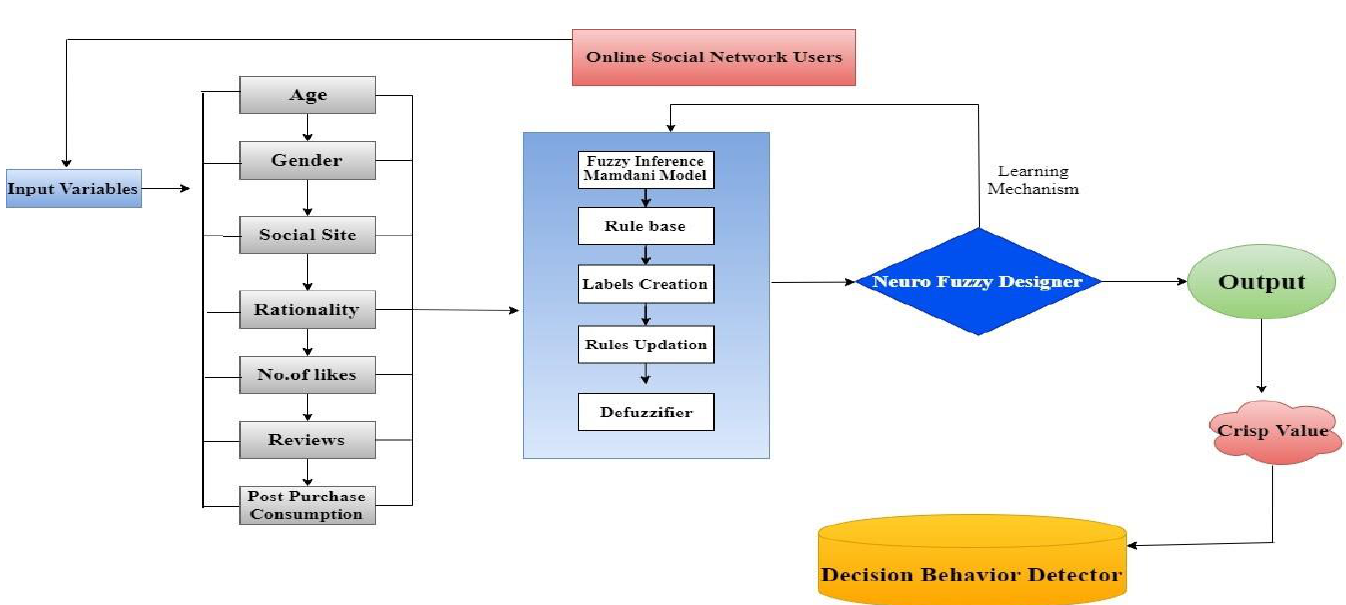
Figure 7. Proposed architecture for decision behavior detection